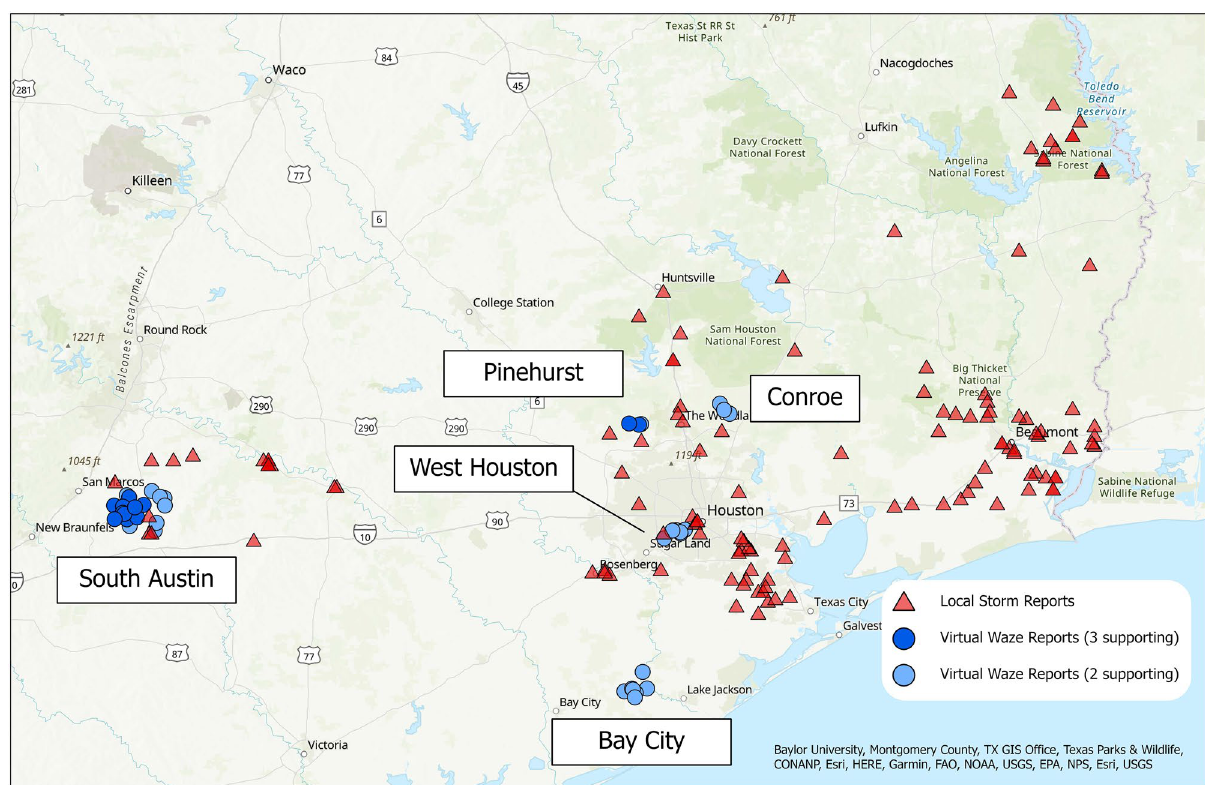
Figure 4. Remaining Virtual Waze Reports after de-duplication. LSRs are denoted by red triangles, VWRs supported by exactly 2 out of 3 configurations of N are shown in light blue, and VWRs supported by exactly 3 configurations are shown in dark blue. Note that while several new spatial clusters are apparent, the temporal dimension of flood reporting is not shown here. Clusters are labeled based on nearby population centers or points of interest. Map created using ArcGIS Pro 71